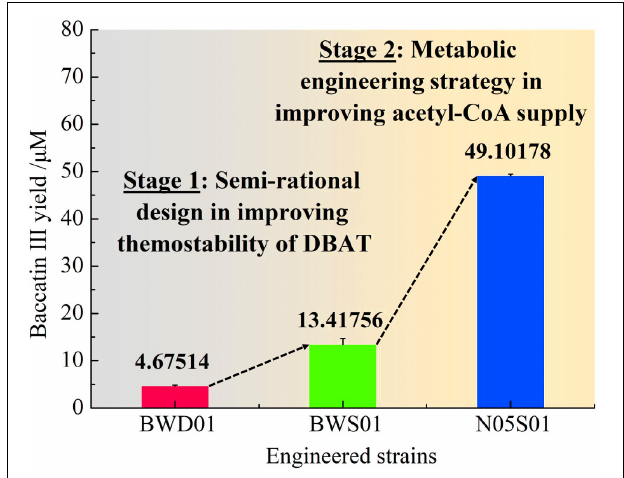
FIGURE 7 | Results of the fermentation of integrated engineered strains to produce baccatin III. Baccatin III production has undergone two stages of improvement. Stage 1, Semi-rational design in improving thermostability of DBAT; Stage 2, Metabolic engineering strategy in improving acetyl-CoA